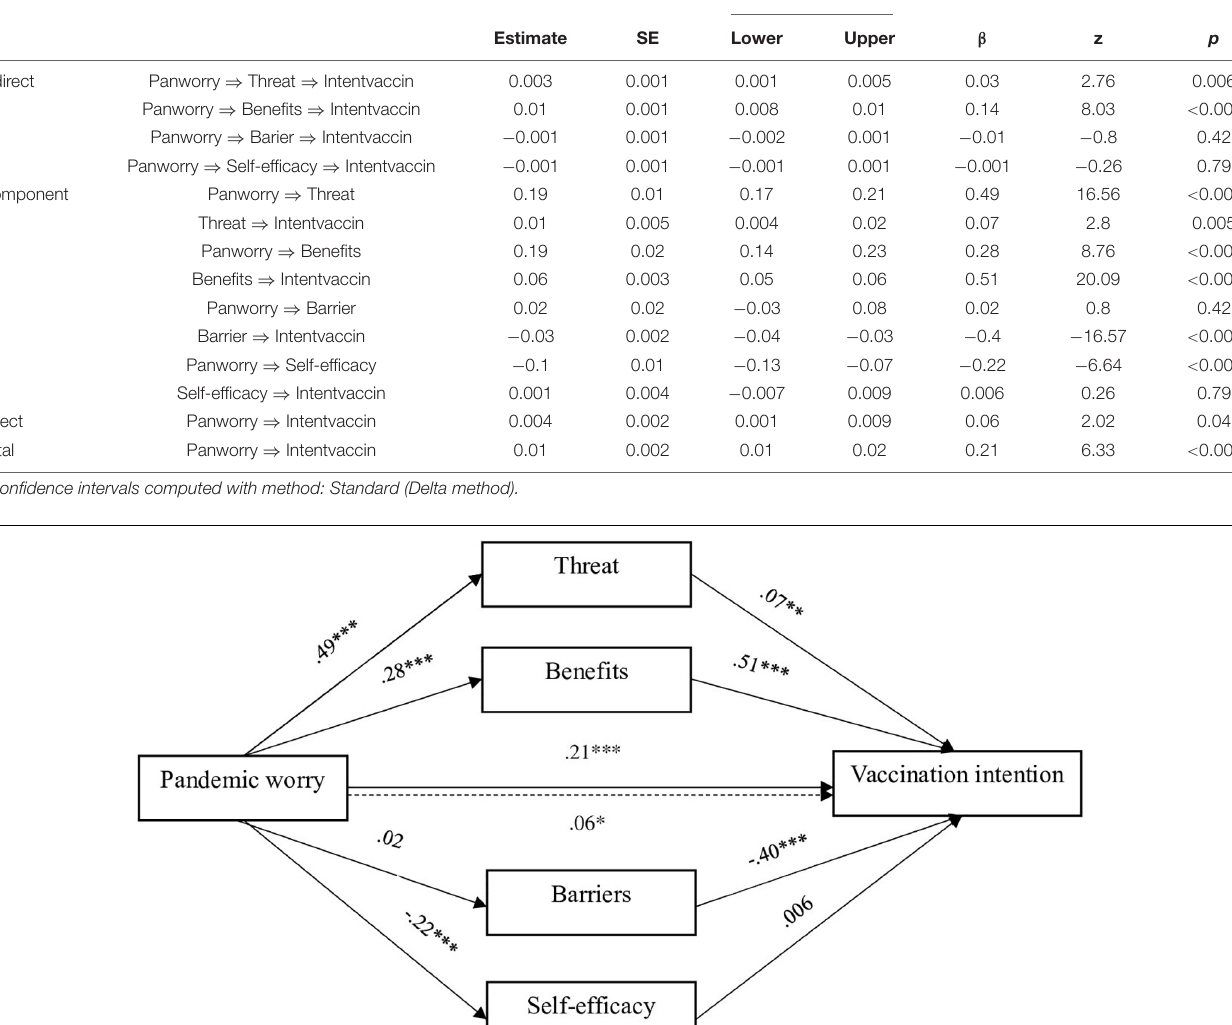
TABLE 3 | Direct, indirect, and total effects of the GLM mediation.